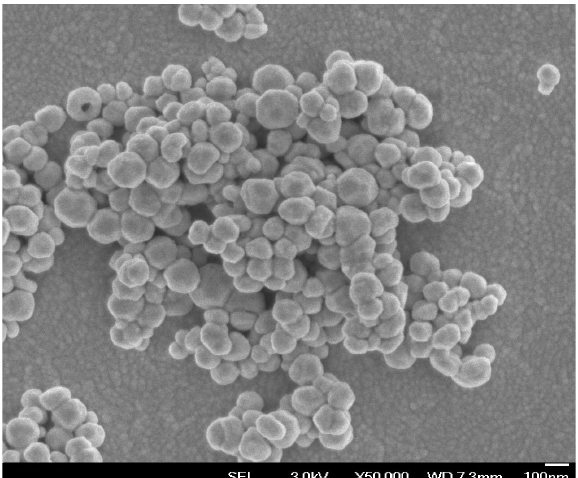
FIGURE 2 - Morphology of paclitaxel and spirulina, shown by SEM imaging. Most paclitaxel and spirulina nanoparticles are circular or